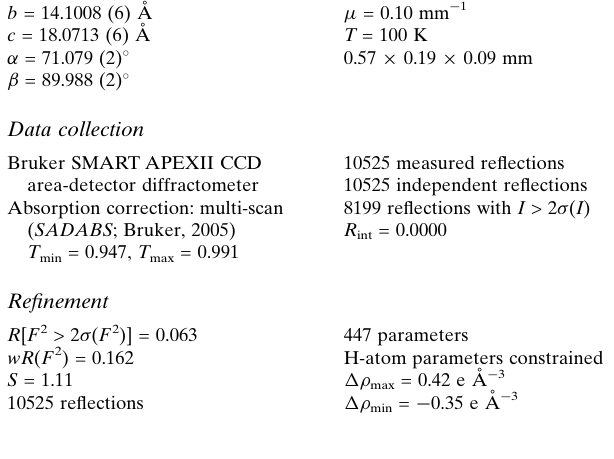
Bruker SMART APEXII CCD area-detector diffractometer